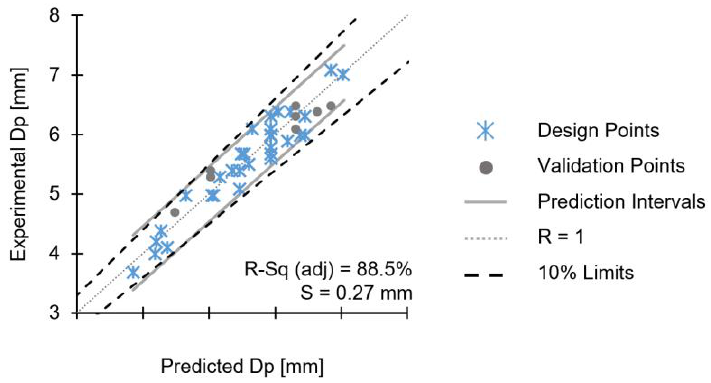
Figure 18. Validation diagrams for the reduced model of Dp.